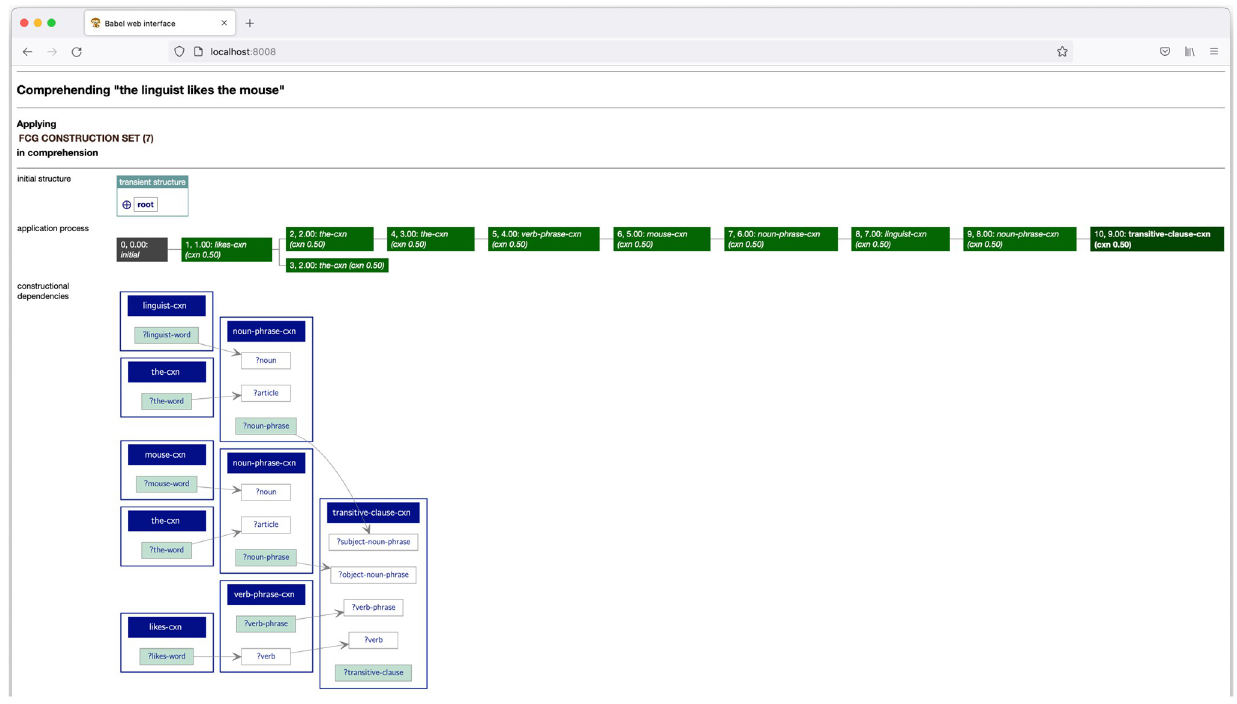
Fig 2. Interactive web interface. The Babel Interactive Web Interface has been integrated into the FCG Editor and is accessible at http://localhost:8008.